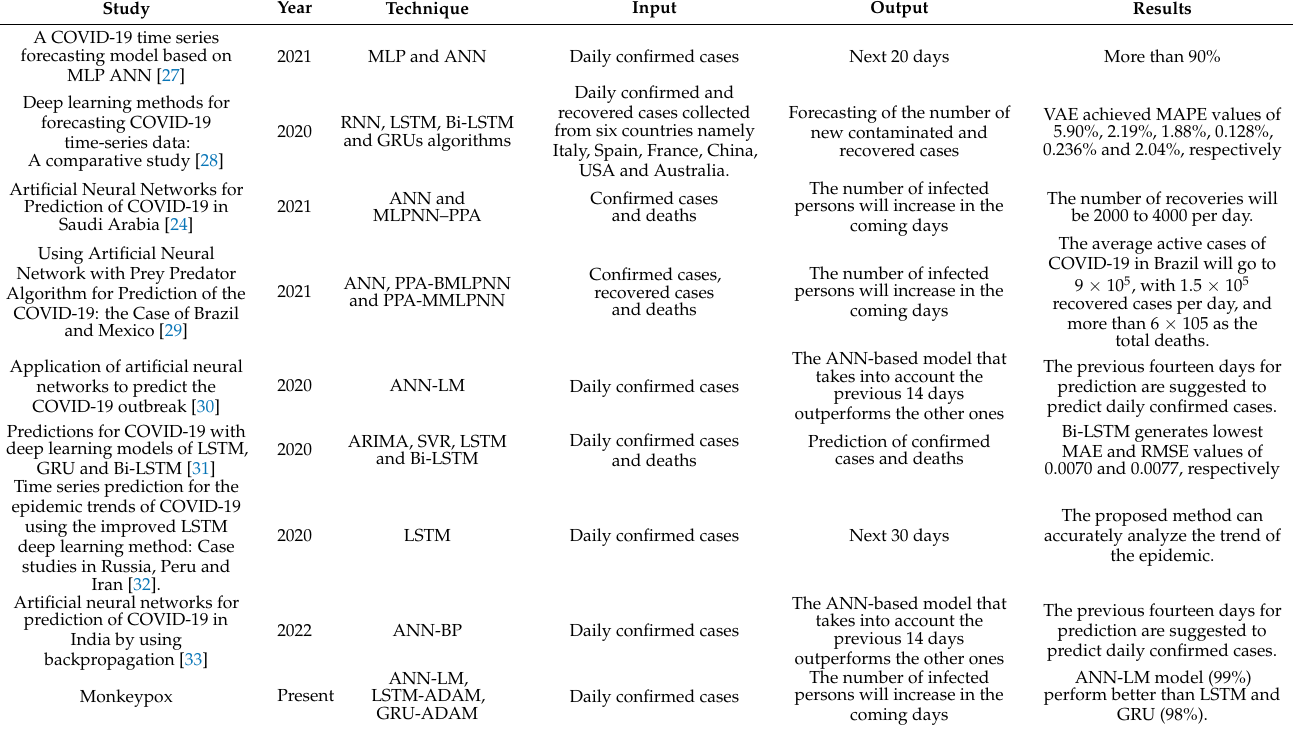
Table 1. Summary of related